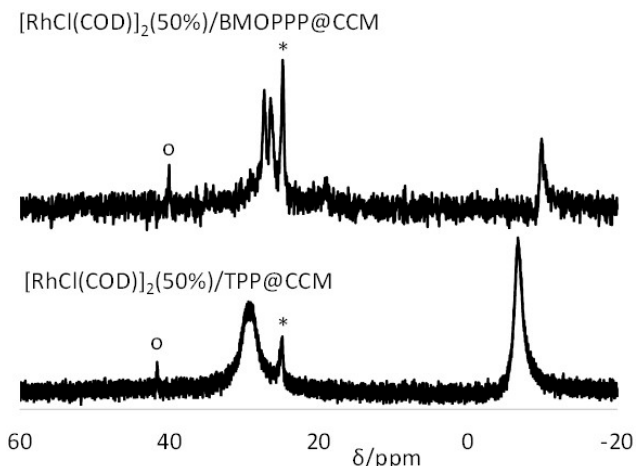
Figure 6. 31 P{ 1 H} NMR spectra of TPP@CCM and BMOPPP@CCM 50% loaded with [RhCl(COD)] 2 in water after swelling with toluene. The corresponding TPP@NG and BMOPPP@NG polymers gave the same result. The starred resonances correspond to the oxidized phosphine impurity. The resonance marked with a circle is an impurity of unknown nature.